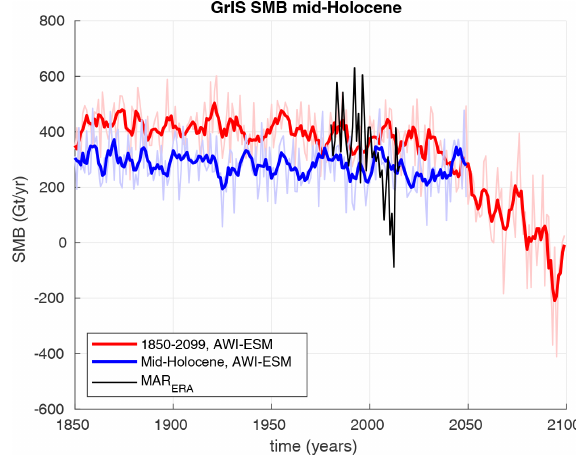
Figure 13. GrIS SMB time series from the experiment Industrial (red), experiment H6K (blue) and experiment MAR ERA (black, Sect. 4). Fine lines show yearly accumulated values, and bold lines represent respective 5-year moving means.